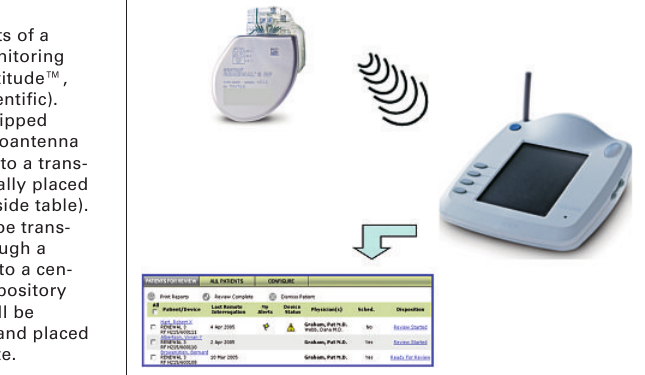
Components of a remote monitoring